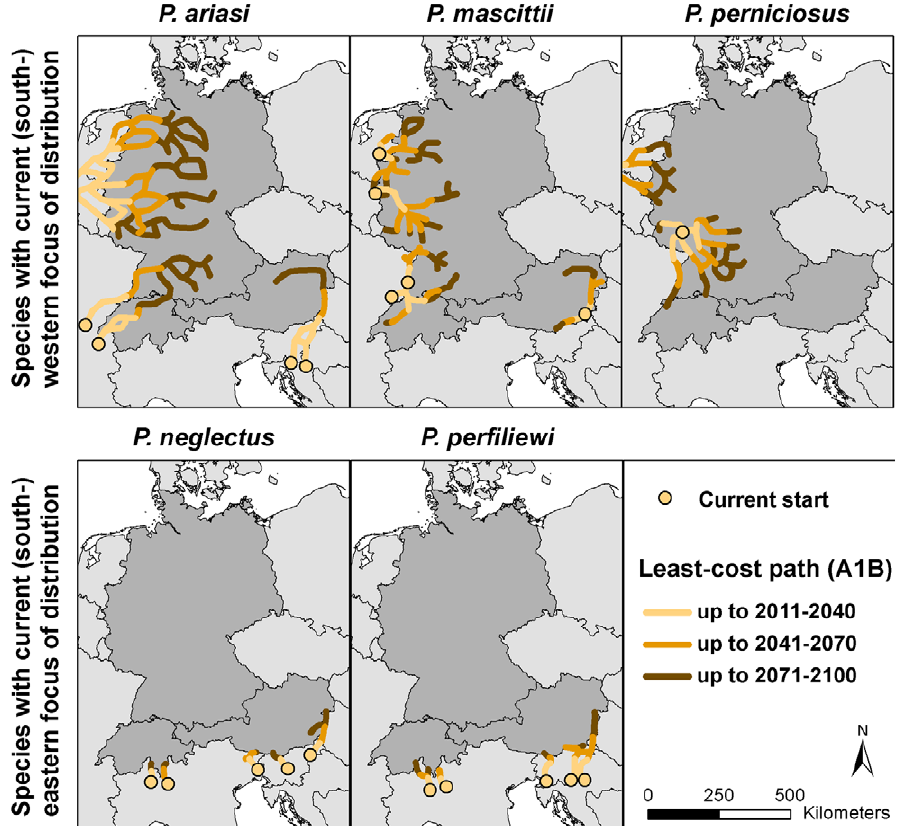
Figure 4. Least-cost paths for Phlebotomus species. The detected pathways indicate direction of spread in the 21 st century. Spatio-temporal varying climatic suitability and wind speed included in the cost surface that must be crossed by species in the 21 st century refer to the A1B scenario.